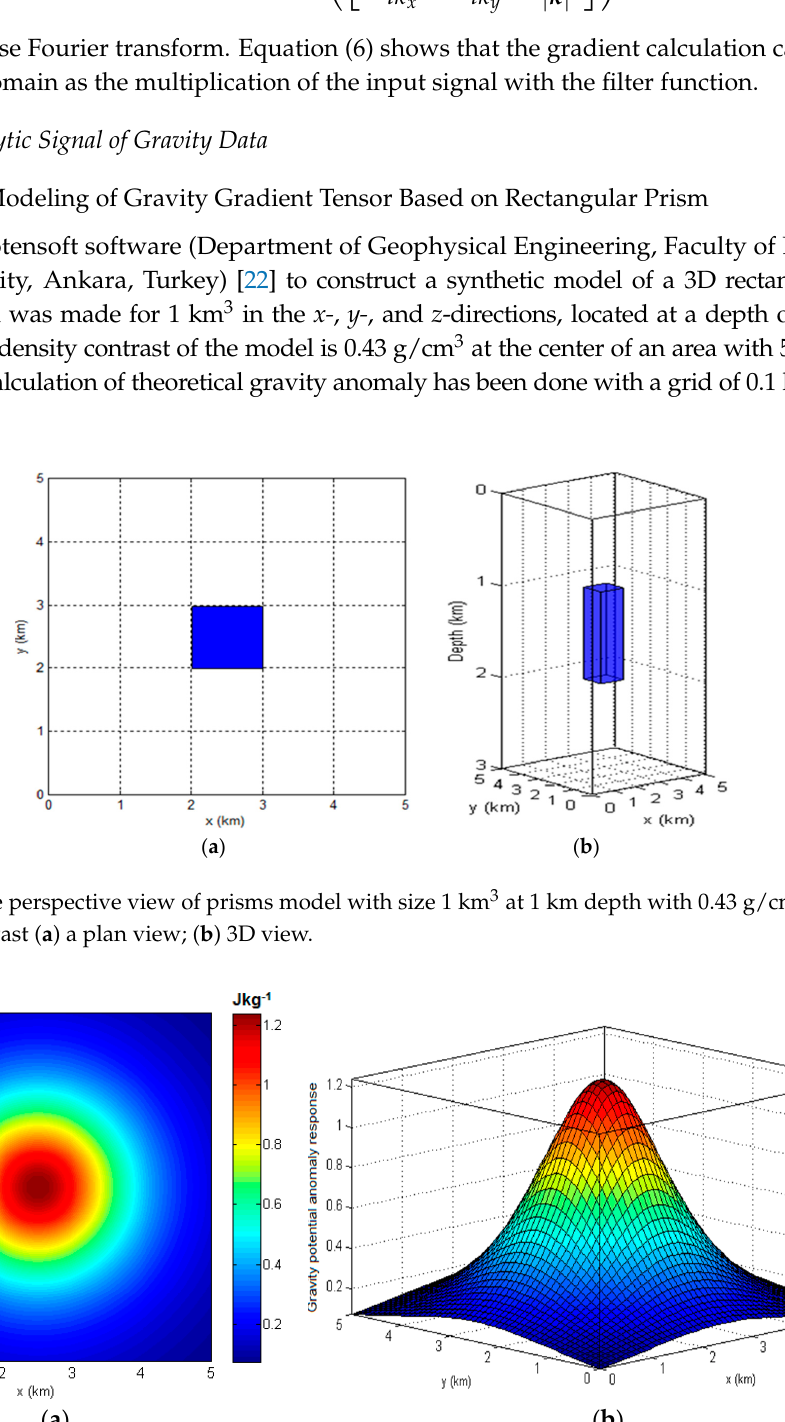
Figure 5. The theoretical response of potential anomaly with size 1 km 3 at 1 km depth with 0.43 g/cm 3 of the density contrast ( a ) a plan view; ( b ) 3D view.